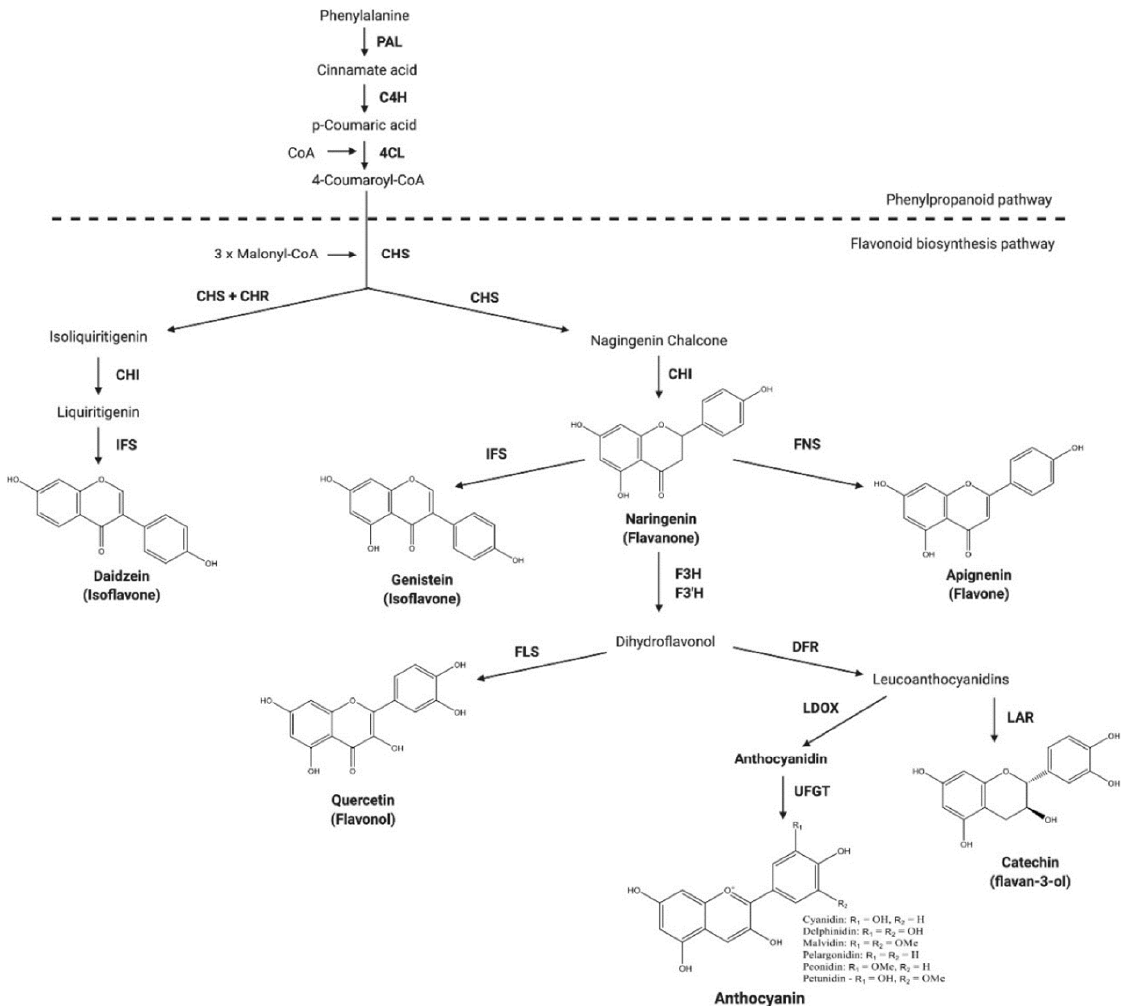
Figure 1. Generalized flavonoid biosynthetic pathway showing the production of genistein from naringenin